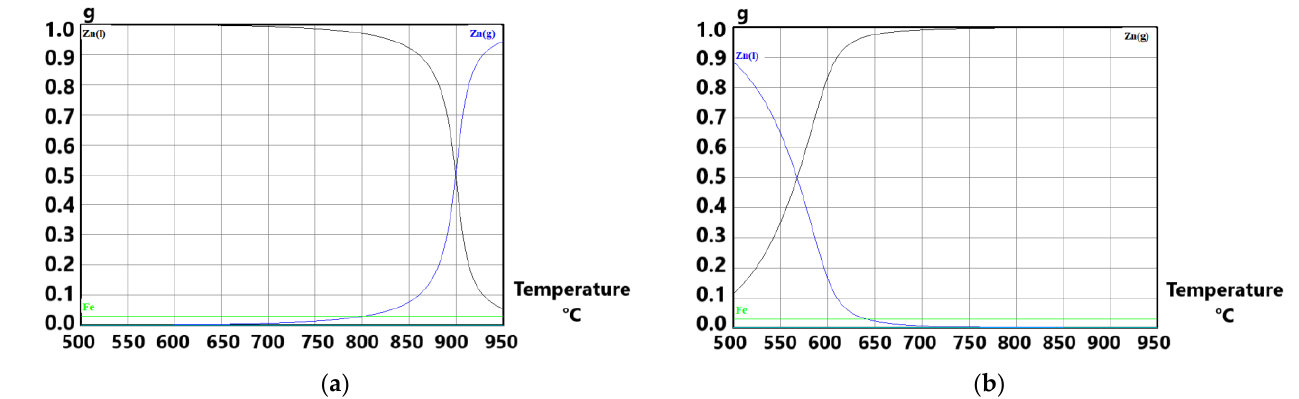
Figure 4. Change of p(Zn) with temperature in the system of (1 g Zn: 0.03 g Fe: Ar): ( a ) 1·10 −3 mol Ar and ( b ) 1 mol Ar (1 g Zn = 0.0153 mol).